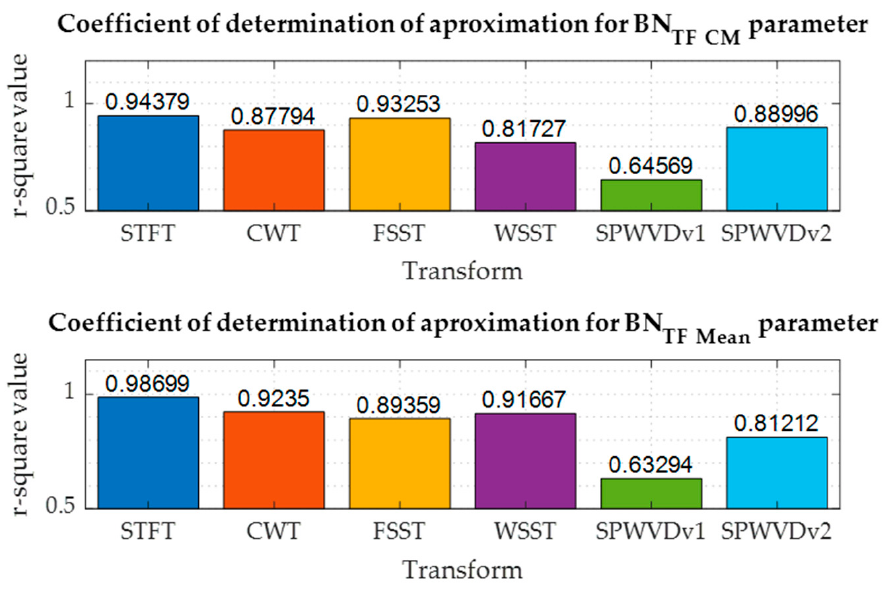
Figure 6. Result of the r 2 coefficient for BN TF_CM and BN TF_MEAN parameters.